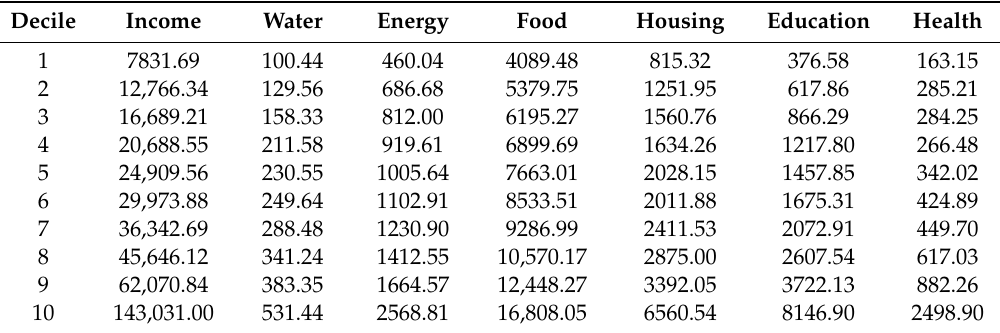
Table 5. Household average expenditure in selected categories per decile of income.